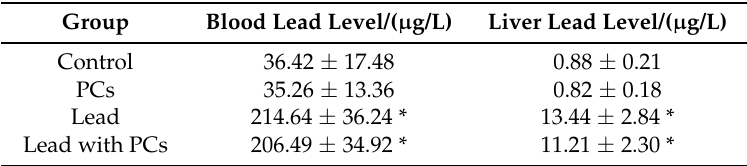
Table 2. Lead contents in serum and liver of mice in each group ( n = 7, X ±